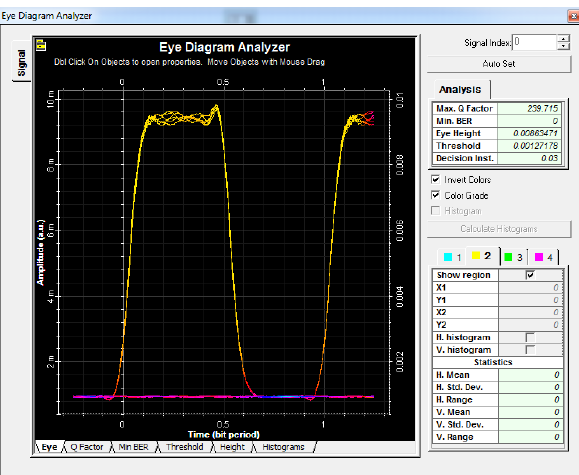
Figure 4: Results of the eye diagram analyzer with the directly modulated laser source along a cable length of 15 km.